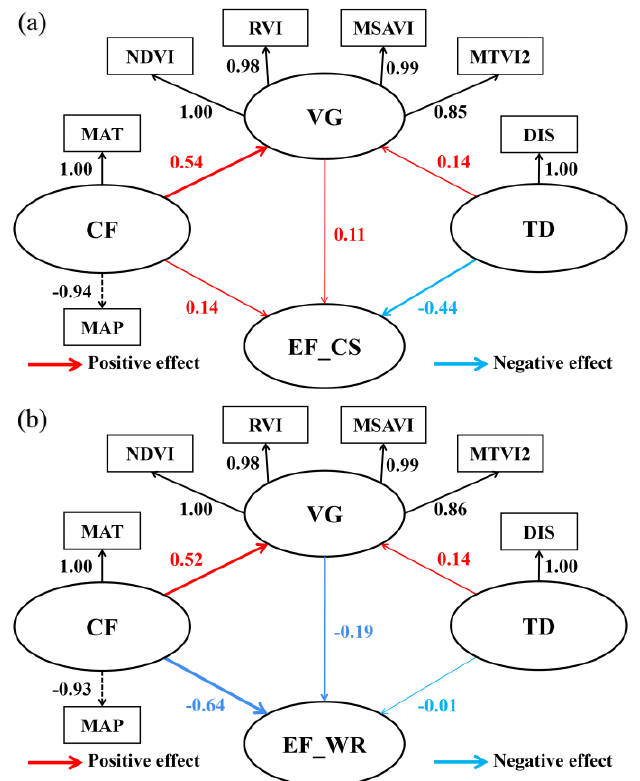
Figure 7. The final best-fit SEM model describing the relationships among the latent variables and their observed variables. Red paths represent positive effects, and blue paths represent negative effects. Numbers and thickness of paths indicate the size of the effect. Variables are tourist disturbance (TD), vegetation growth (VG), climate factors (CF), mean annual temperature (MAT), mean annual precipitation (MAP), tourist disturbance (TD), normalized difference vegetation index (NDVI), ratio vegetation index (RVI), modified soil-adjusted vegetation index (MSAVI), modified triangular vegetation index-improve (MTVI2), calculated disturbance (DIS), water retention (EF_WR), and carbon sequestration (EF_CS).